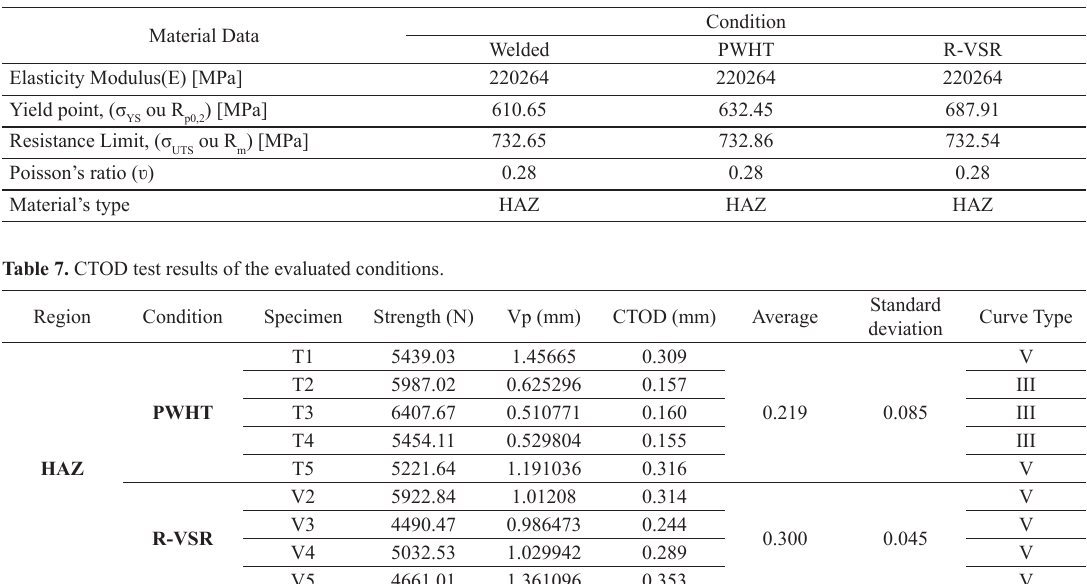
Table 6. Domex 700 MC steel data for CTOD calculation.